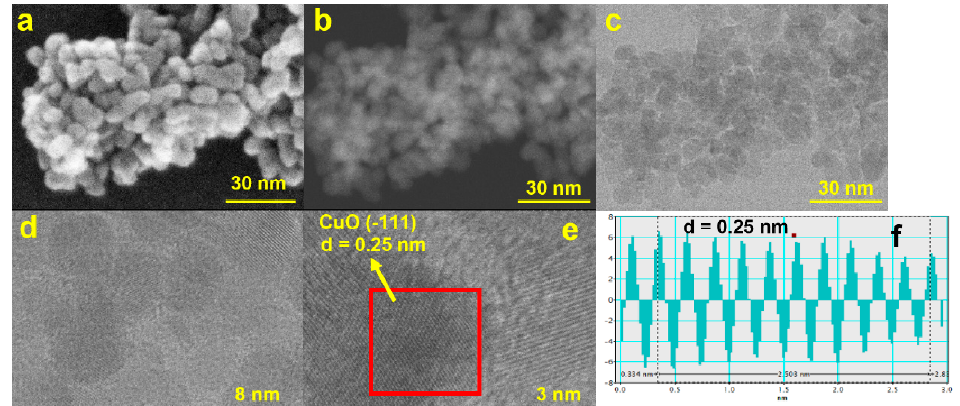
Figure 4. STEM micrographs for the CuONP material using ( a ) SE—secondary electrons, ( b ) ZC—phase contrast, and ( c ) TE—transmission electron detectors; ( d ) HR-STEM image at ×4000 K and ( e ) ×8000k magnification and the corresponding profile for d-spacing measurements ( f ).